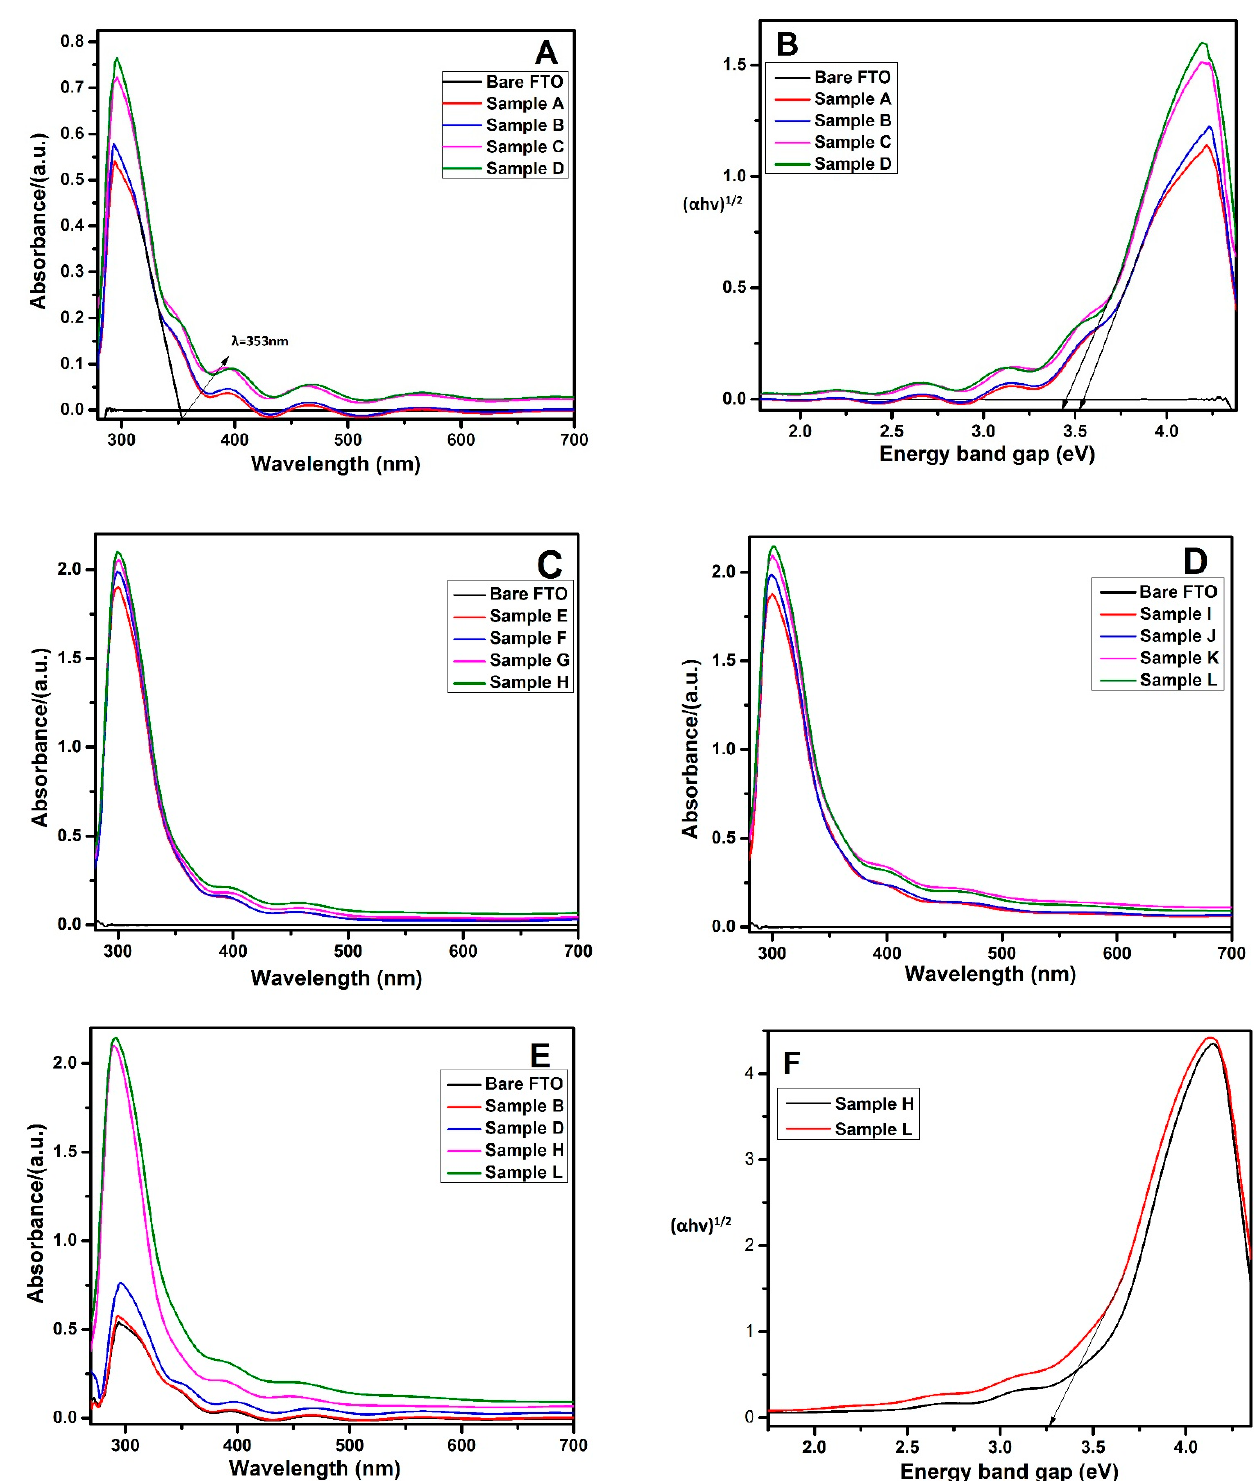
Figure 5. UV-Vis absorption Spectra ( A , C – E ) and tauc plot for corresponding energy band gap values ( B , F ). Band alignment and band gap are other important characteristics that describe the optical features of a photocathode. The energy band gap values of all of the prepared films were determined through Tauc’s method, given in Equation (4) [91].